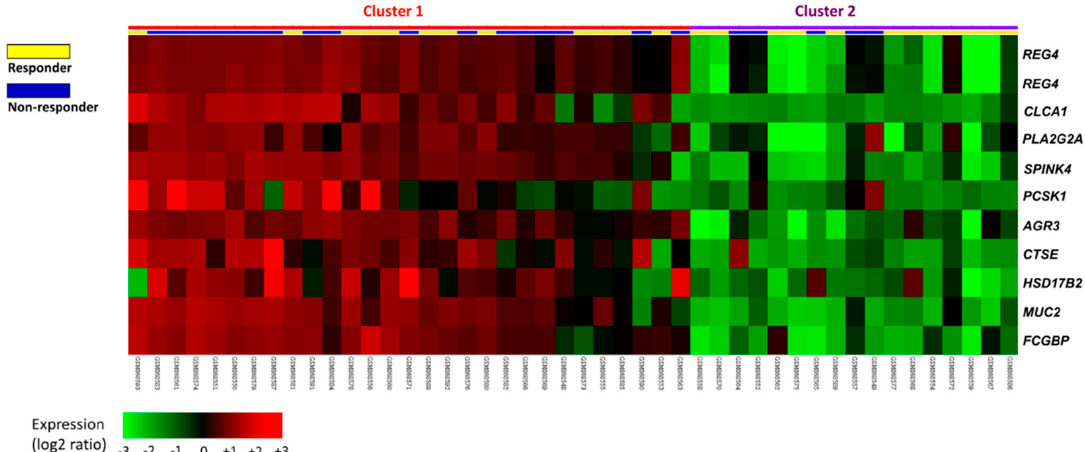
Figure 1. Expression profiles of the top 10 differentially expressed genes linked to CCRT resistance from a public transcriptome dataset (GSE35452) in the GEO database. All probes were analyzed without preselection. The statistical significance of each transcript was examined by comparing responders to nonresponders. The expression levels of upregulated and downregulated genes are marked in red and green, respectively. The SPINK4 gene was identified as one of the most significantly upregulated genes among CCRT nonresponders. Table 1. Summary of the top 10 differentially expressed genes associated with CCRT resistance in rectal carcinoma.